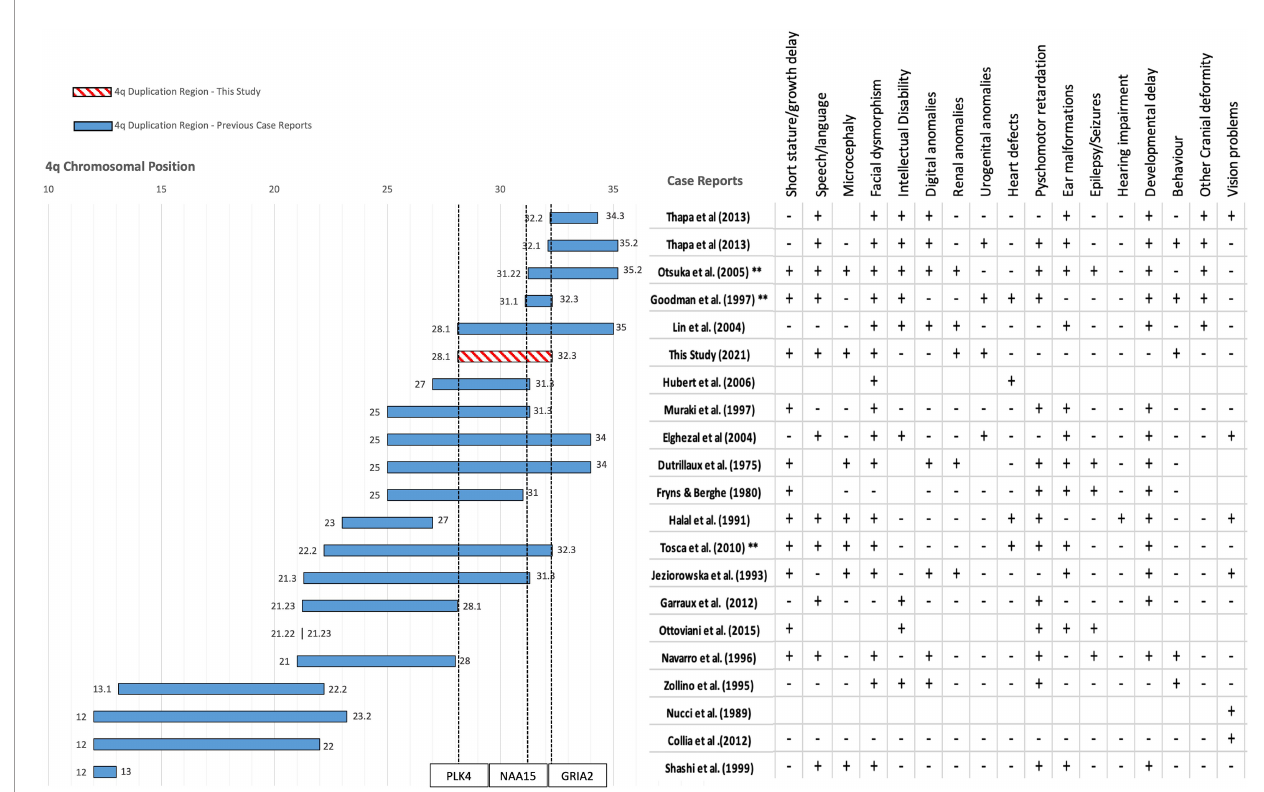
FIGURE 2 | Mapping the duplication region of our patient against 23 other patients of similar pure 4q chromosome duplications from 19 published case reports obtained from literature. Filled bars show the interstitial duplication sizes of previously reported cases. Location is reported as chromosomal band size on the x axis. The axis leading to 0 represents the centromere and the opposite end represents the telomere. Chromosomal coordinates in base pairs (bps) are given in the Supplementary Table S2 . The two patients from Thapa et al. (2013) each have a distinct duplication. The number of patients affected with each duplication is represented by the number of asterisks * symbols next to the citation on the y axis. The region reported by our study is shown with a pattern fi lled bar and includes the region of 4q28.1-32.3. The start and end of each region is mentioned as a data label at the beginning and end of each bar. Each case mentioned presents a different combination or spectrum of phenotypes. The table on the right of the plot represents the clinical presentation of speci fi c phenotypes indicated on the fi rst row in each of the case reports. + sign indicates the presence of the phenotype and a – sign indicates absence, blank boxes represent no available